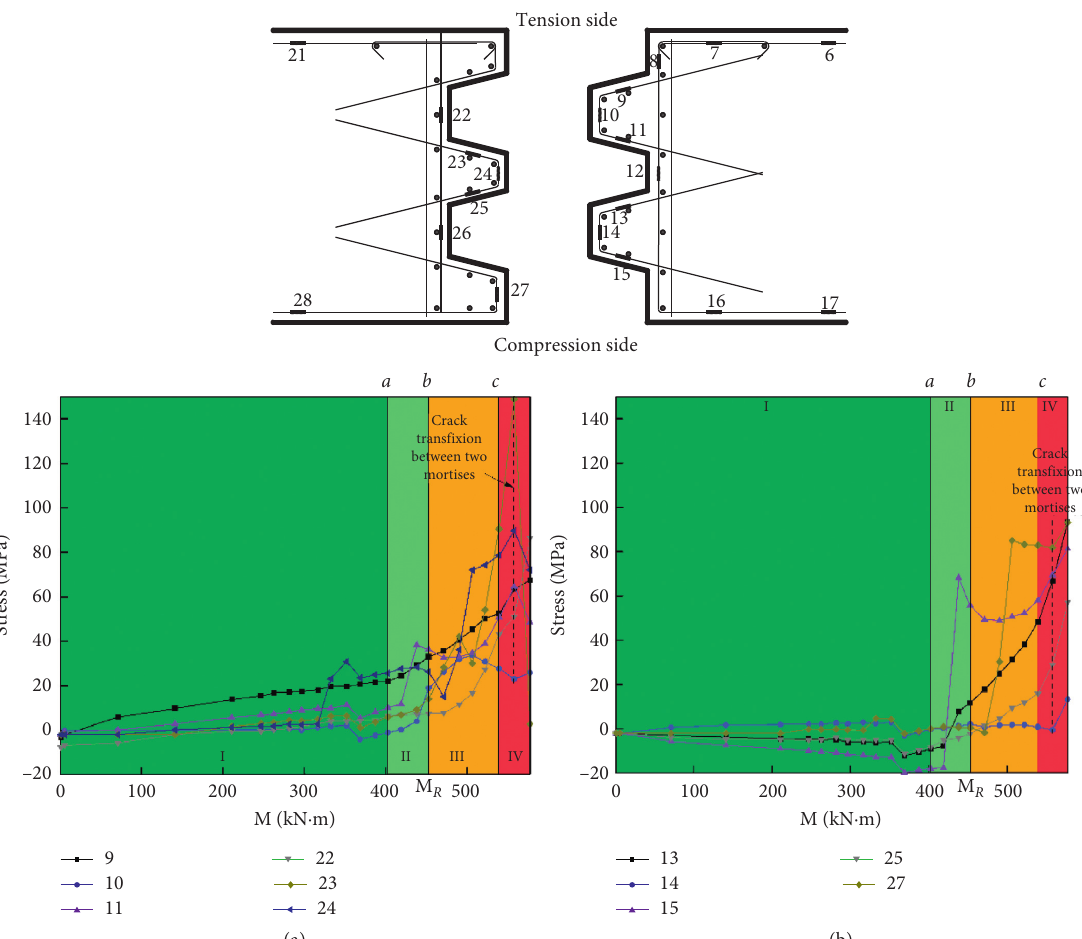
Figure 12: Change curve in reinforcement with bending moment (without auxiliary pretightening device).